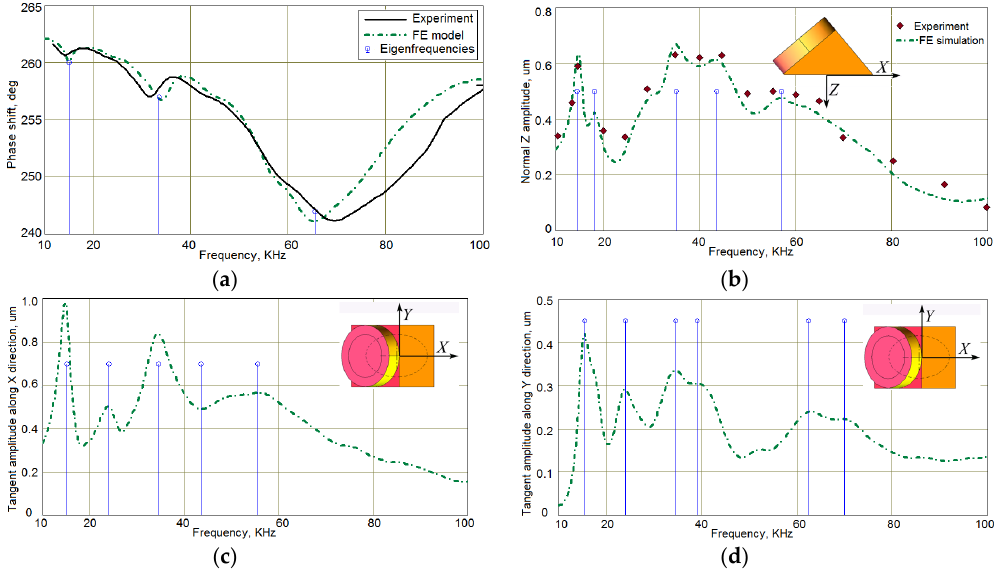
Figure 4. The frequency response functions for the Olympus actuator: ( a )—phase angle of PZT current; ( b – d )—averaged displacement amplitudes on the contact footprint surface—normal ( b ) and tangential ( c , d ).